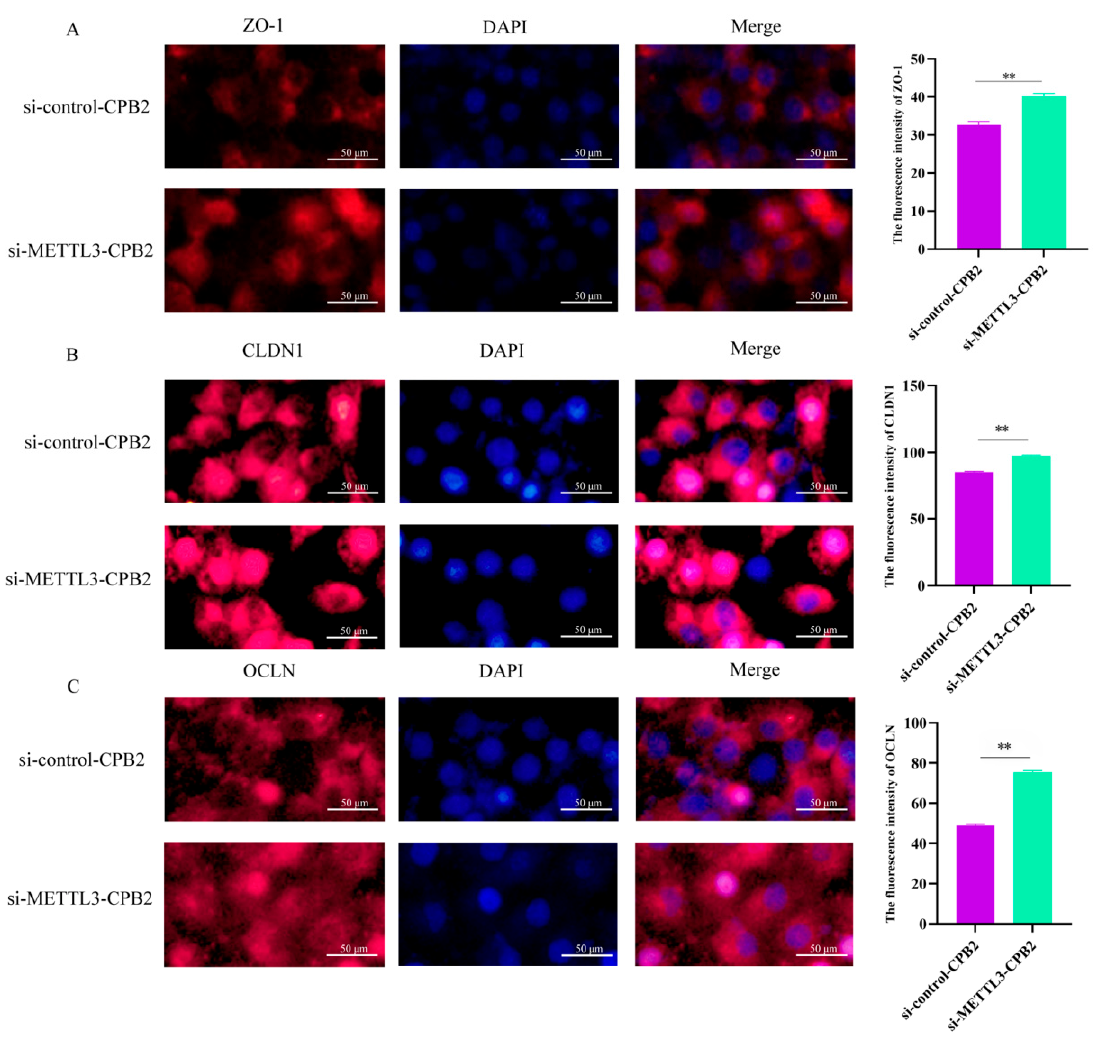
Figure 6. Tight junction protein expression after METTL3 knockdown after CPB2 toxin treatment. ( A – C ) CLDN1, ZO-1, and OCLN immunofluorescence intensity in the si-control-CPB2 and si-METTL3-CPB2 groups. As a secondary antibody, IgG/Cy3 was utilized. The intensity of the red fluorescence represents the level of protein expression. The blue colour represents cell nucleus. Three bar graphs depict group annotations. The scale bar is 50 µ m. All of the data are based on three separate experiments and are given as mean ± SD. ** p < 0.01.